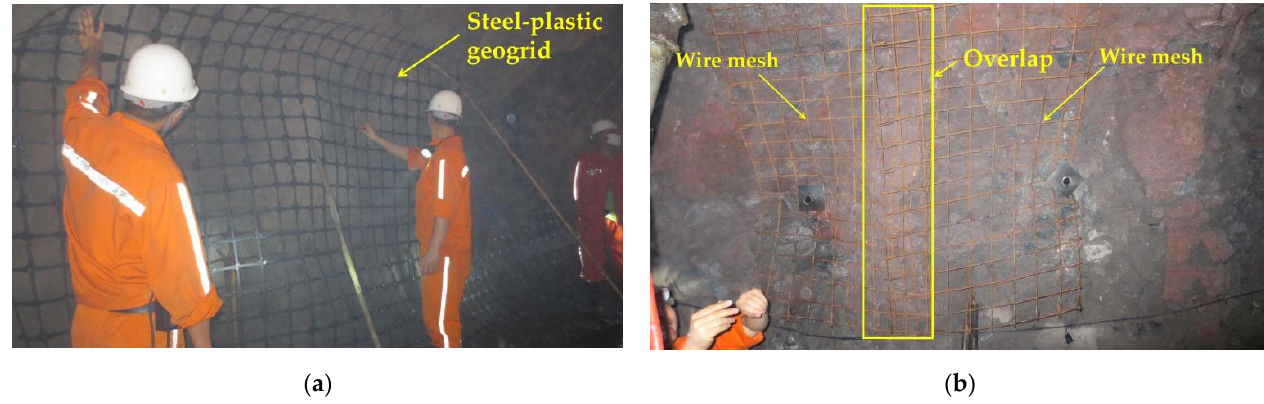
Figure 14. Comparison of on-site construction processes: ( a ) steel-plastic geogrid; ( b ) wire mesh.